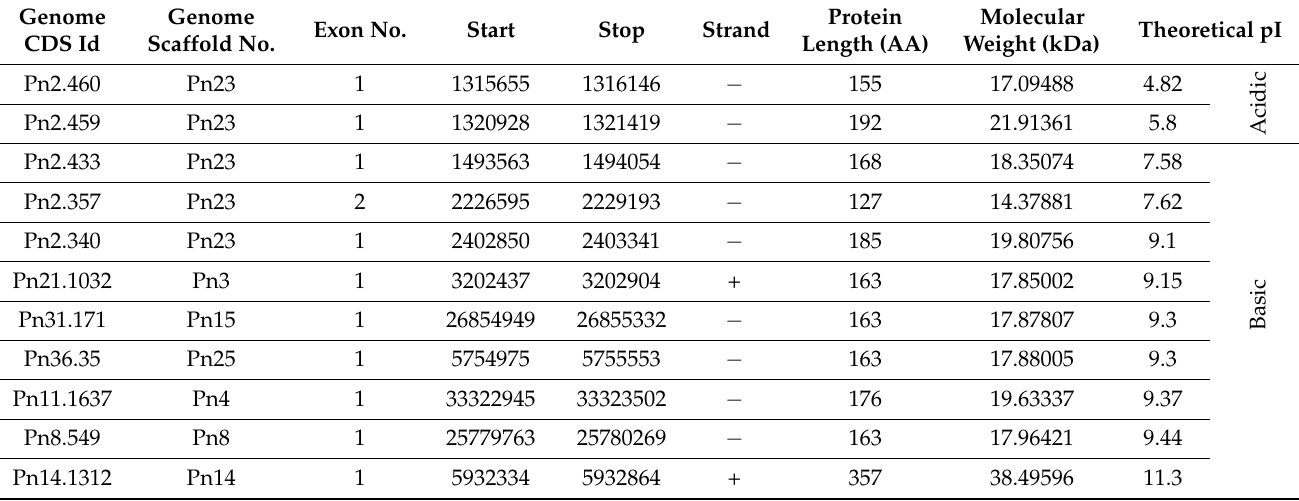
Table 1. Sequence characteristics and physio-chemical properties of the PR-1 proteins in Piper nigrum . Genome Genome CDS Id Scaffold